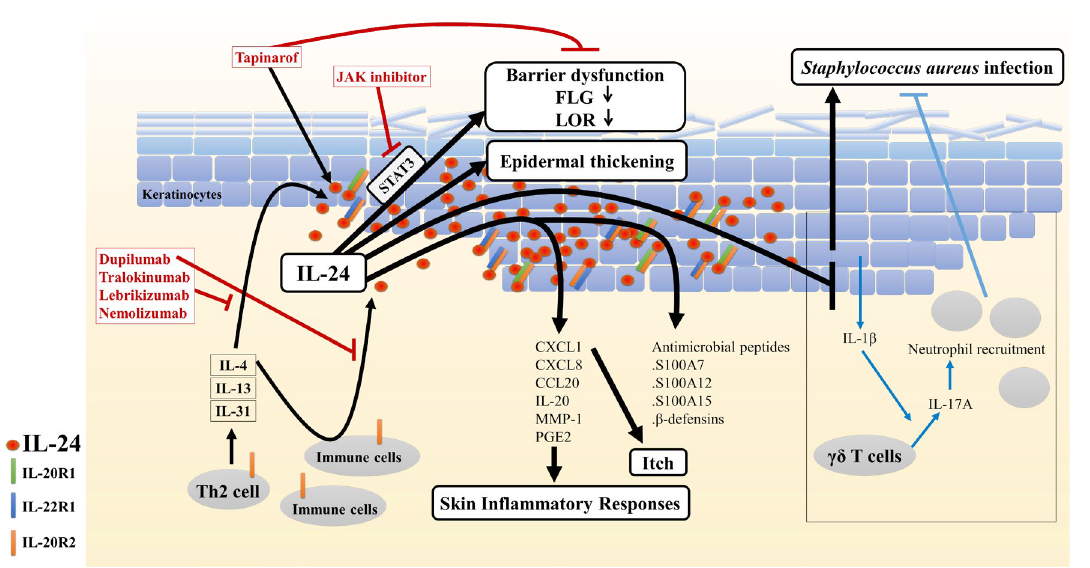
Figure 2. Potential role of IL-24 in AD. Type 2 cytokines stimulate immune cells and keratinocytes to secrete IL-24, leading to the upregulation of IL-24 expression in the epidermis of AD skin. Furthermore, IL-24 contributes to skin barrier disruption and hyperplasia in AD, and it may exacerbate skin inflammatory responses, itch, and S. aureus infection. Therefore, therapeutics that suppress IL-24 signaling, including the IL-4/IL-13 antagonist dupilumab, IL-13 antagonists tralokinumab and lebrikizumab, IL-31Rα antagonist nemolizumab, and JAK-STAT inhibitors, might be promising for managing AD, including combination use with